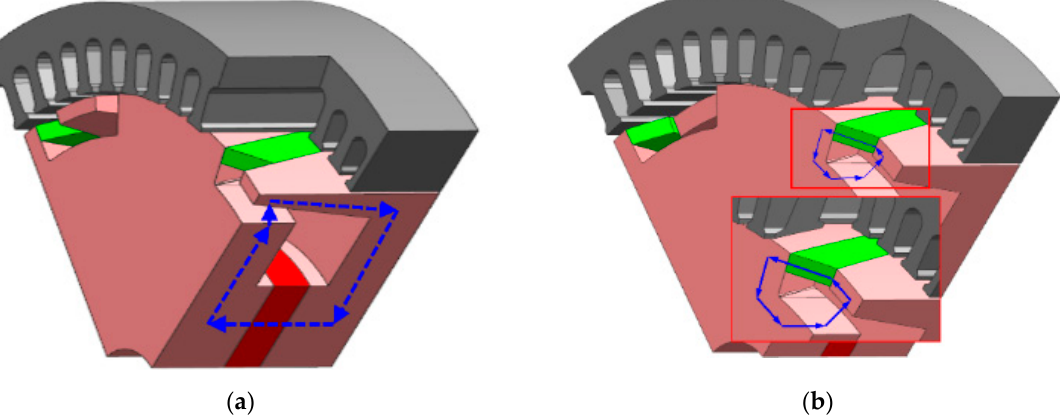
Figure 4. Schematic diagram of the leakage flux path of claw pole generator. ( a ) The first main magnetic circuit; ( b ) the second main magnetic circuit.